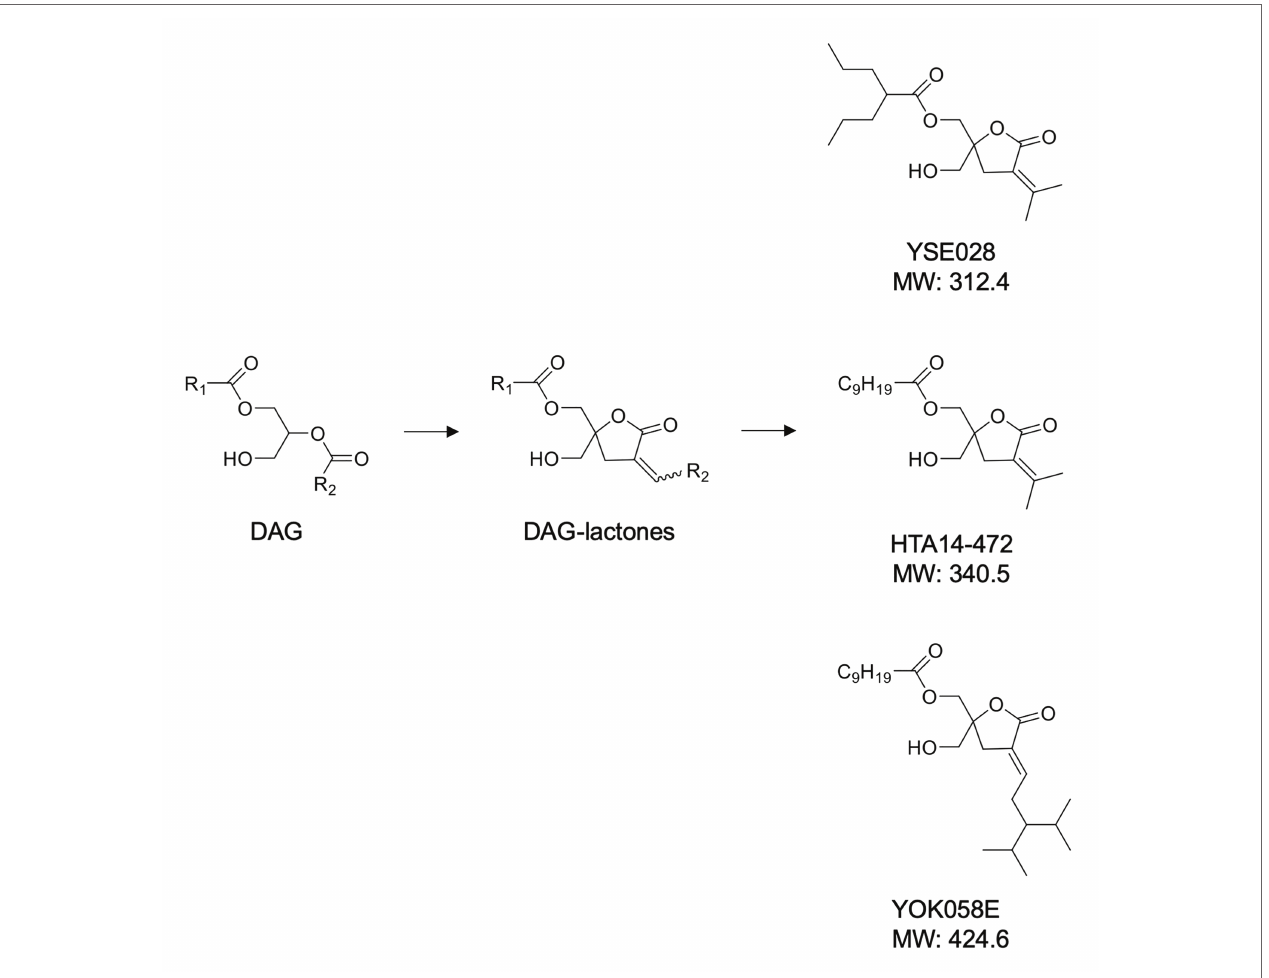
FIGURE 1 | Structures of diacylglycerol (DAG)-lactone